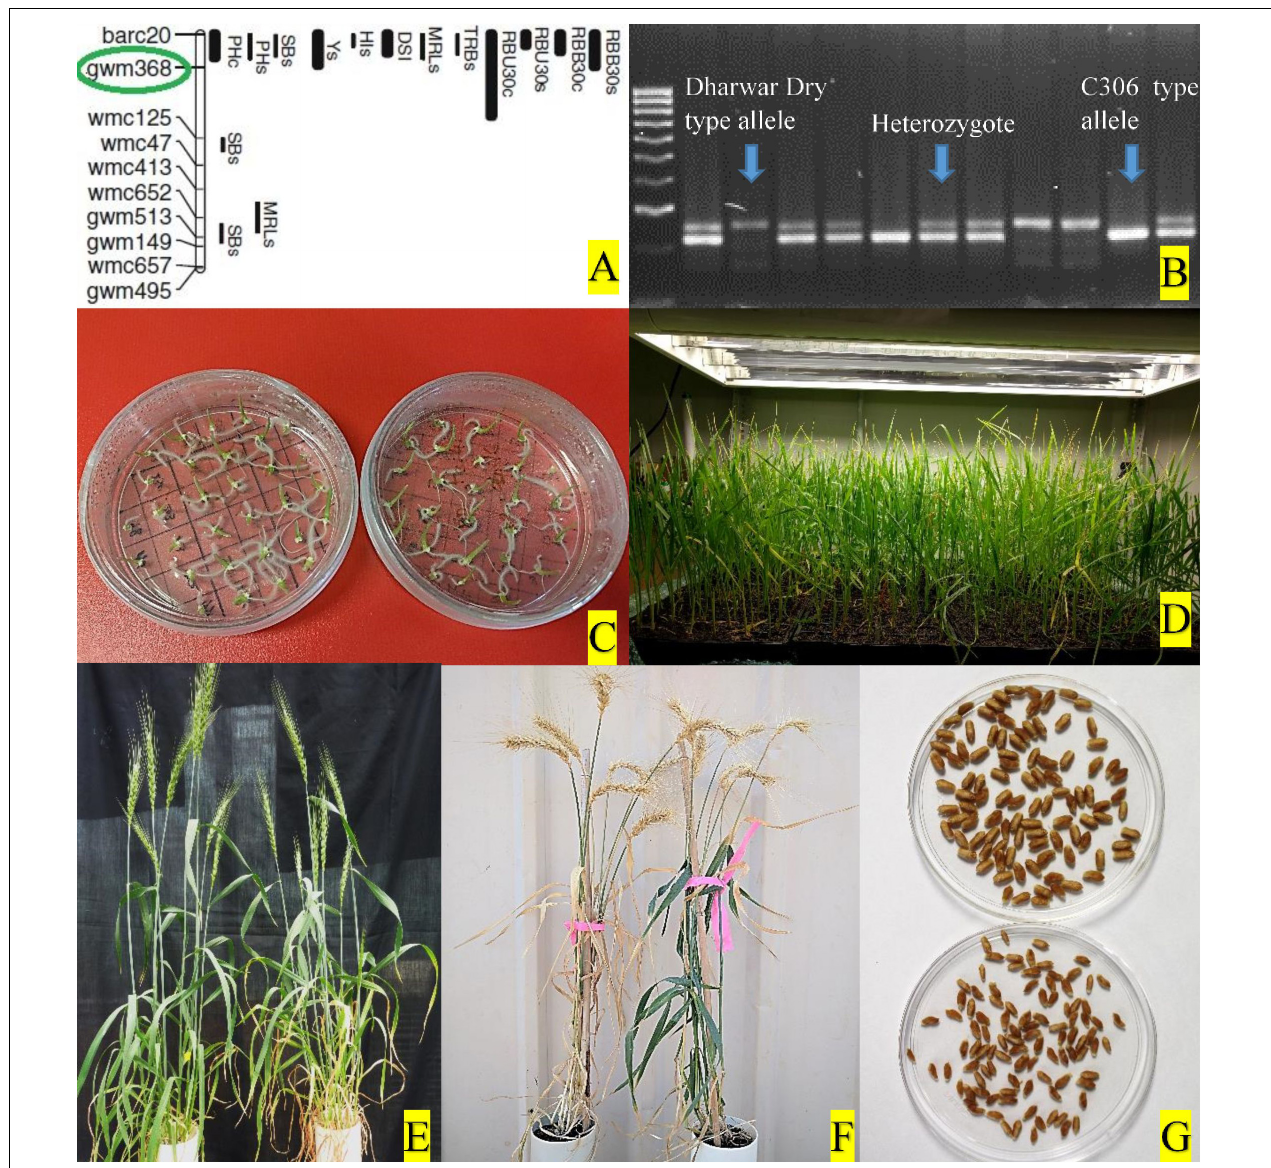
FIGURE 2 | (A) QTL hotspot in wheat chromosome 4BS and the marker (circled in green) used for selection, adapted from Kadam et al. (2012). (B) Selection of different progeny types using molecular marker. (C) Culture of young embryos on petri-plates with sterile media. (D) Young seedlings from embryo culture growing in plant growth chamber. (E) NIL pair at anthesis in glasshouse. (F) NIL pair at physiological maturity. (G) Hundred seeds of a NIL